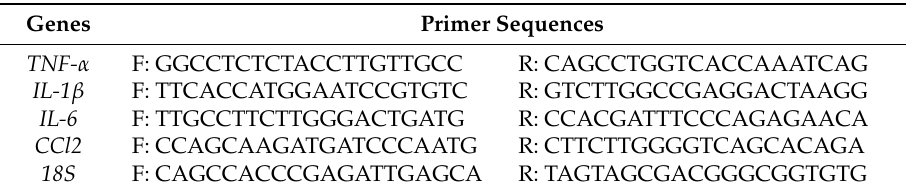
Table 1. List of mouse primer used for real-time